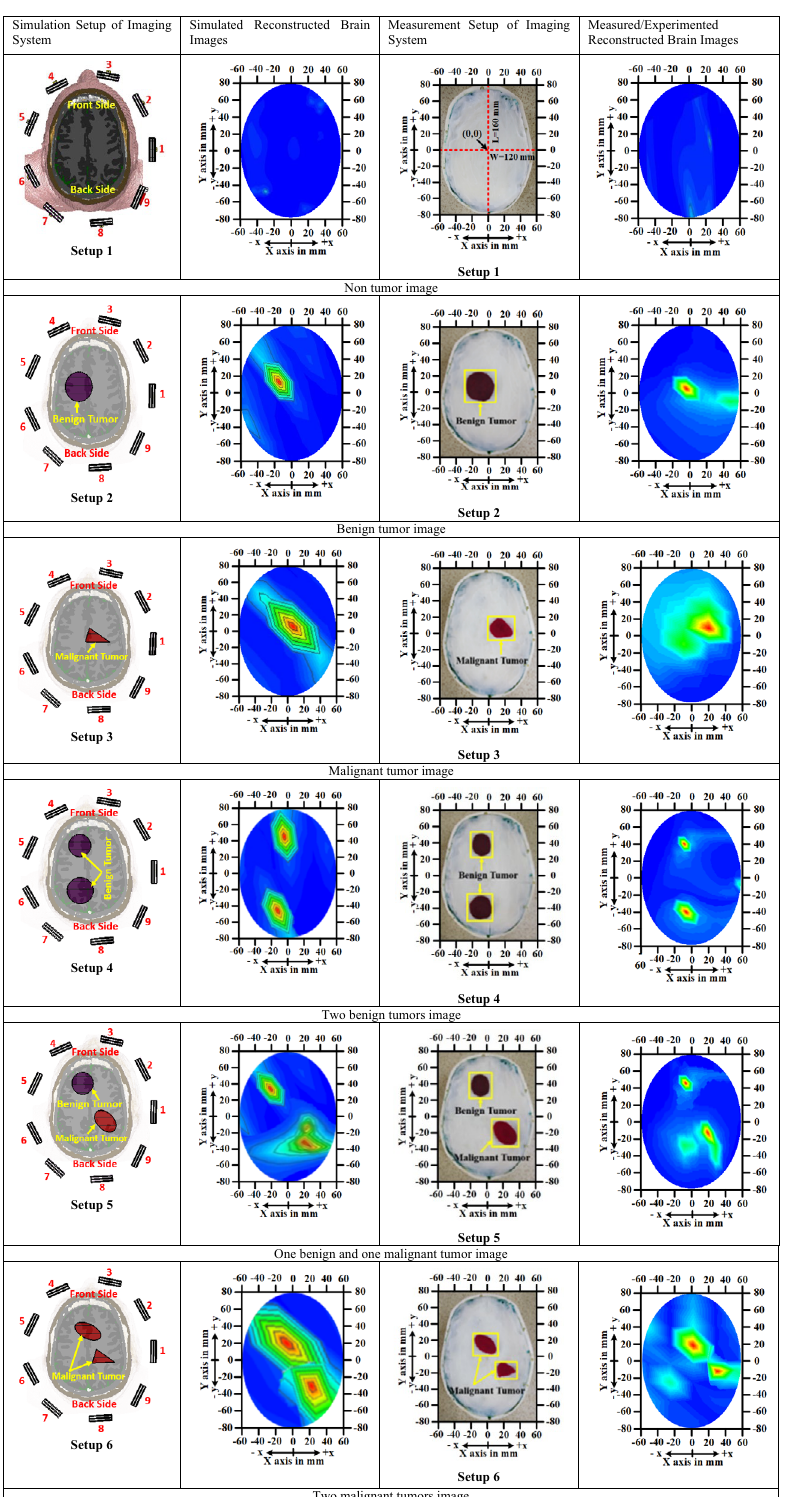
Table 7. Comparison between simulation and measurement/experimental imaging setup with tumor